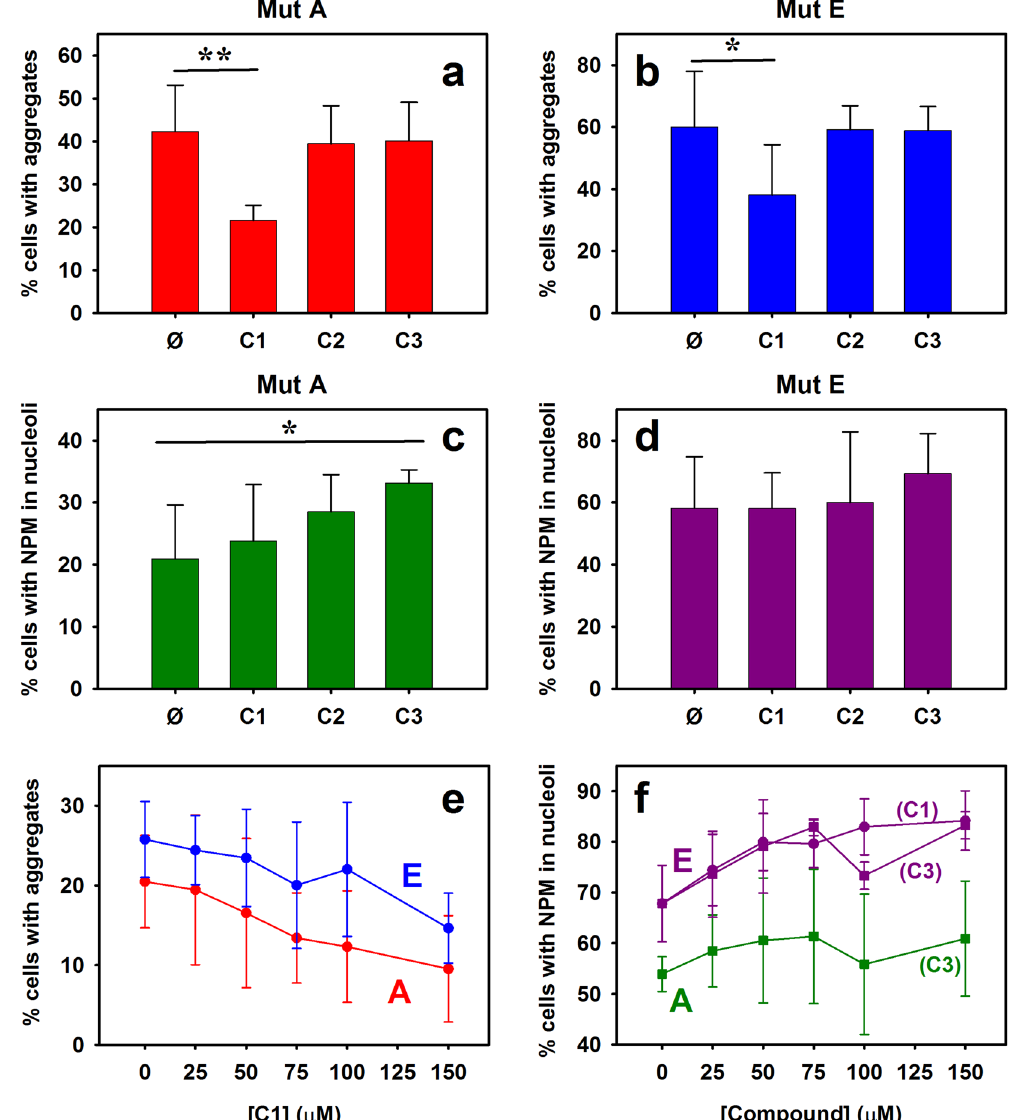
Figure 7. Effect of treatments with the compounds on HeLa cells transfected with NPM mutants. Percentage of cells containing aggregates ( a and b ) and displaying maximum YFP intensity in the nucleoli ( c and d ), for mutant A ( a and c ) and mutant E ( b and d ). Values shown are averages of at least 4 experiments ( ≥ 200 cells per experiment), and the corresponding SD ( * P < 0.05; ** P < 0.01). Aggregation ( e ) and nucleolar localization ( f ) of NPM mutants as a function of compounds concentration. Data for C1 are displayed with circles and for C3 with